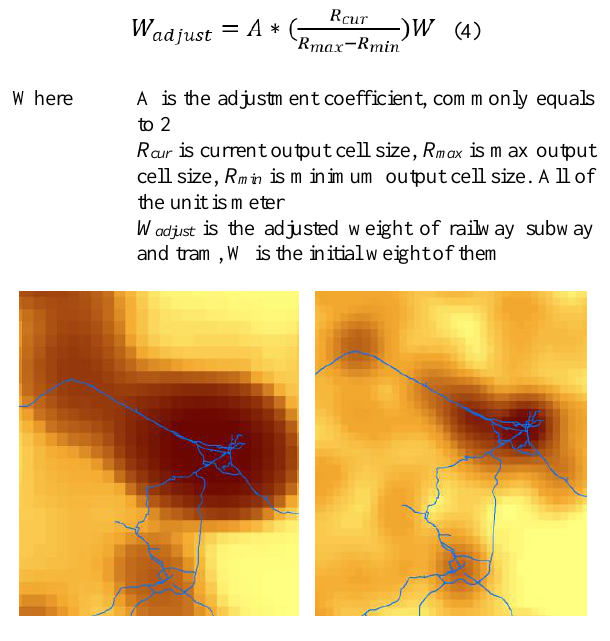
Figure 11. Different cell size of heat map in Tehran The above images showed the different heat map value in Tehran of Iran with different output cell size. The left image’s cell size is 9 kilometres and the right image is 5 kilometres,